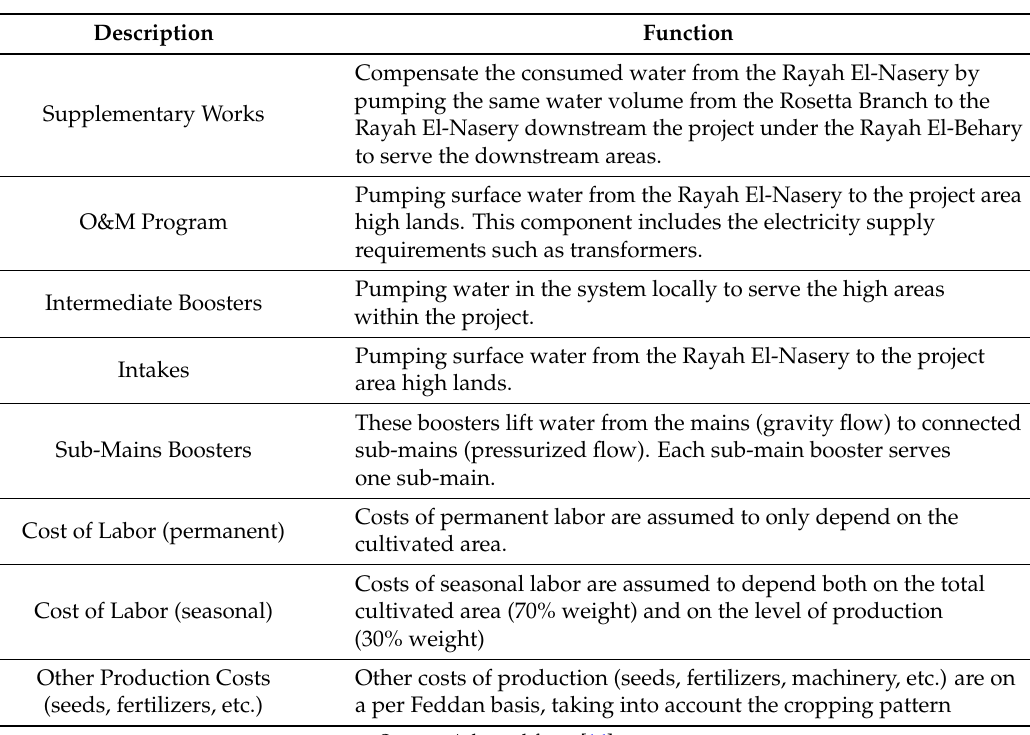
Table A2. Running Cost Categories under Scenario